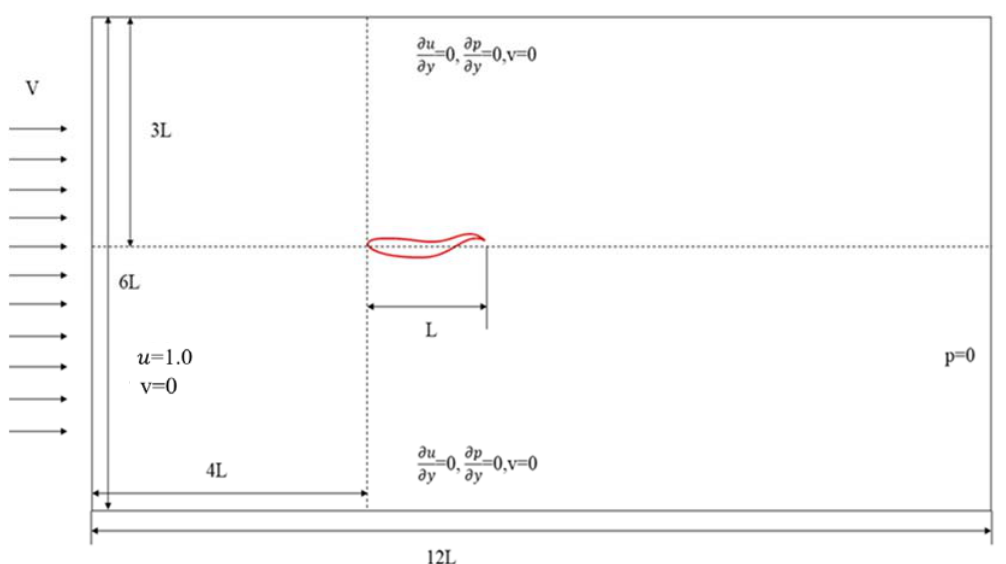
Figure 6. Simulation domain and the corresponding boundary conditions.